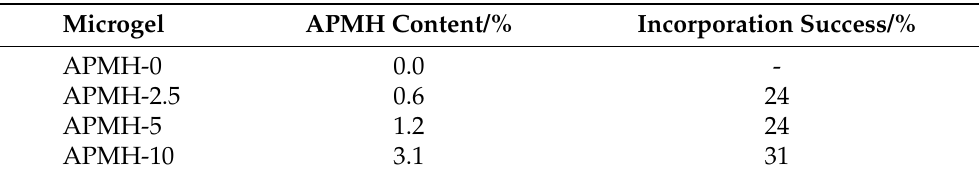
Table 2. APMH content in the microgels relative to the amount of NIPAM, measured by 1 H-NMR